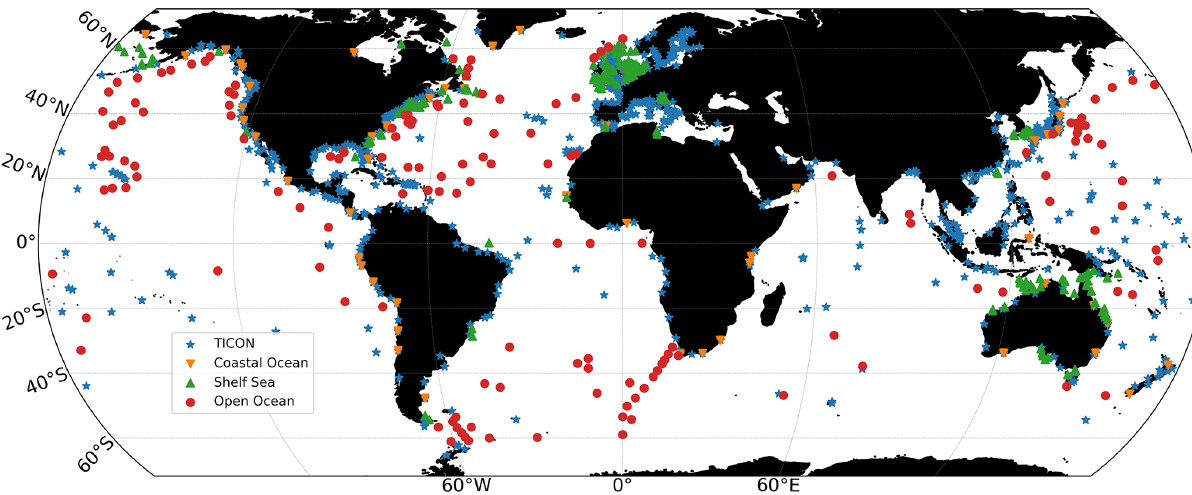
Figure 4. The global array of tide gauges and ocean bottom pressure sensors that were used in the validation of the EOT20 model from the TICON dataset and from Stammer et al. (2014): the coastal ocean, shelf sea and open ocean